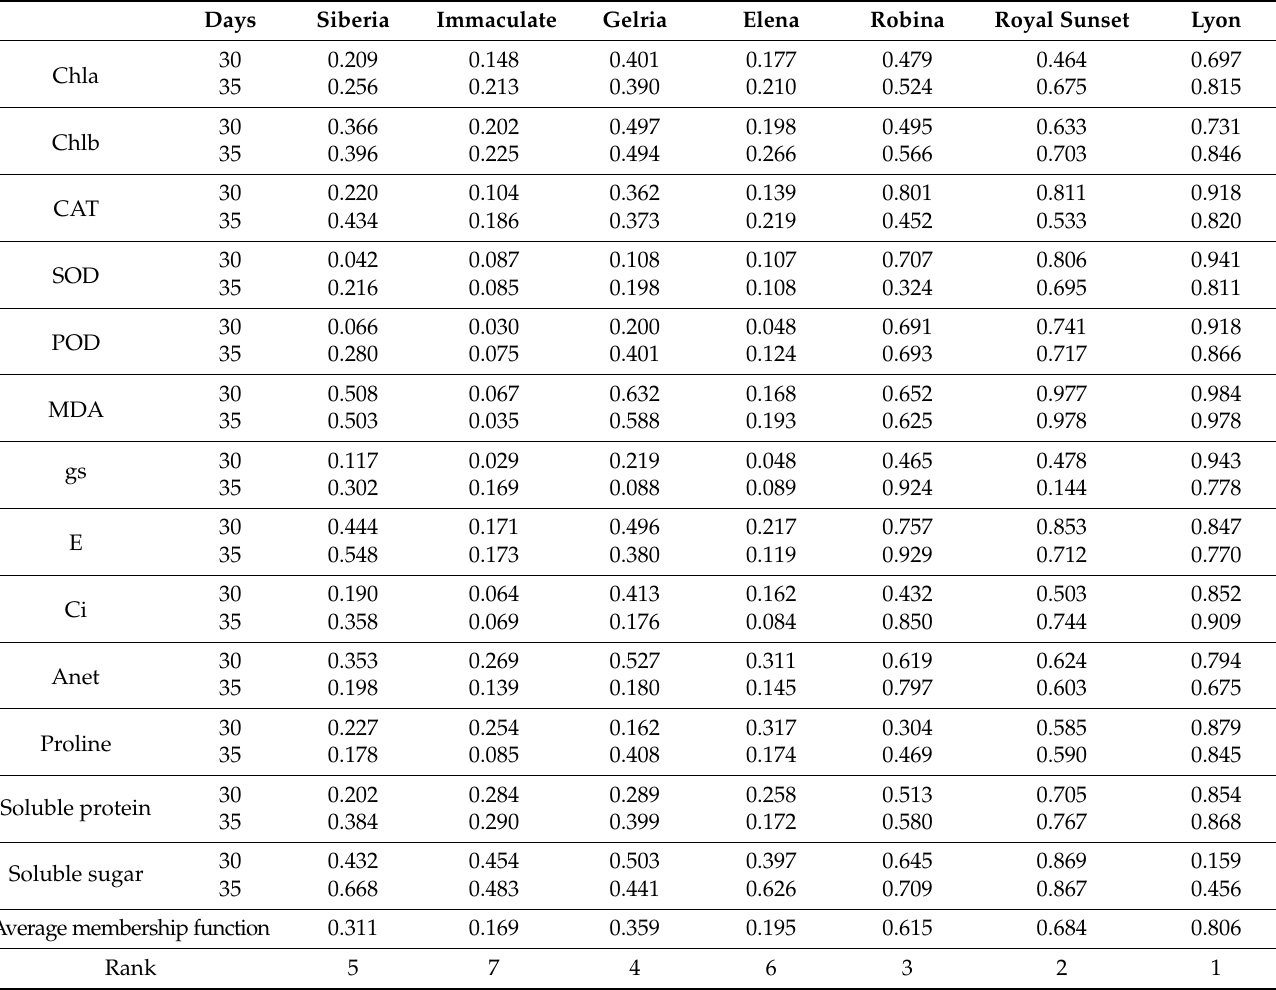
Table 4. Membership function value and drought resistance ranking of